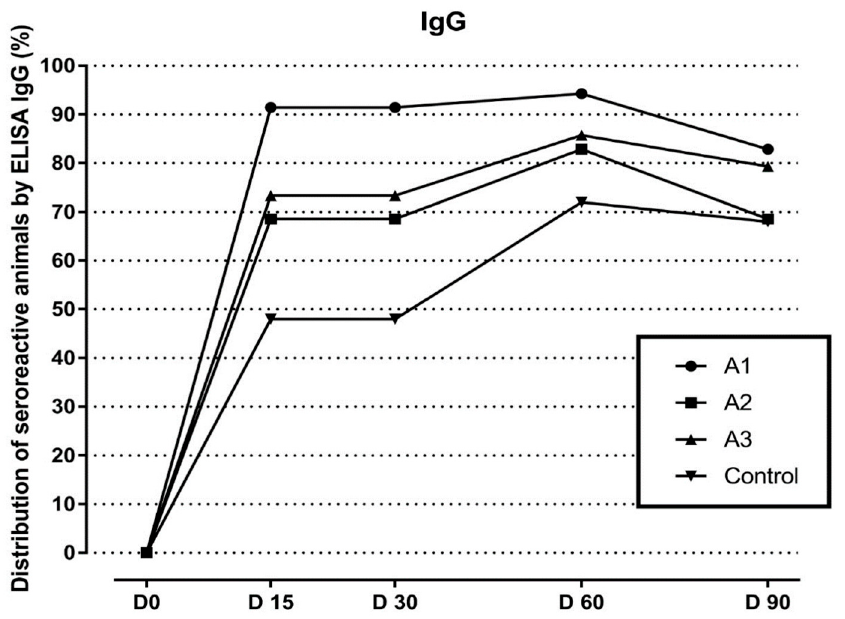
Figure 2. Distribution of seroreactive animals in the anti-Lipl32-IgG ELISA among vaccinated (A1, A2, and A3) and unvaccinated (control) groups.